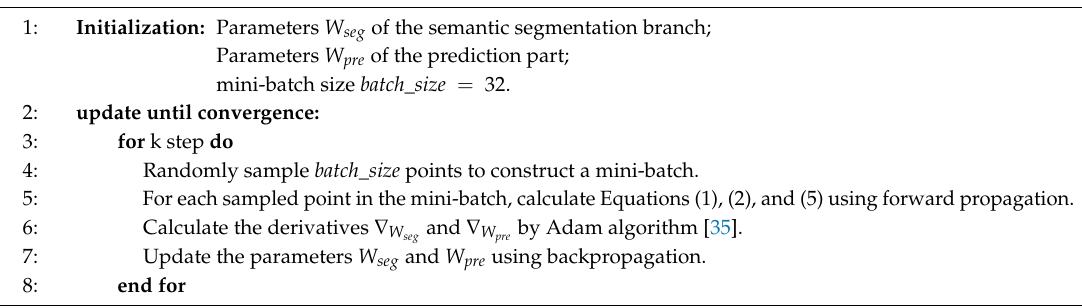
Algorithm 1 Entire process of the proposed